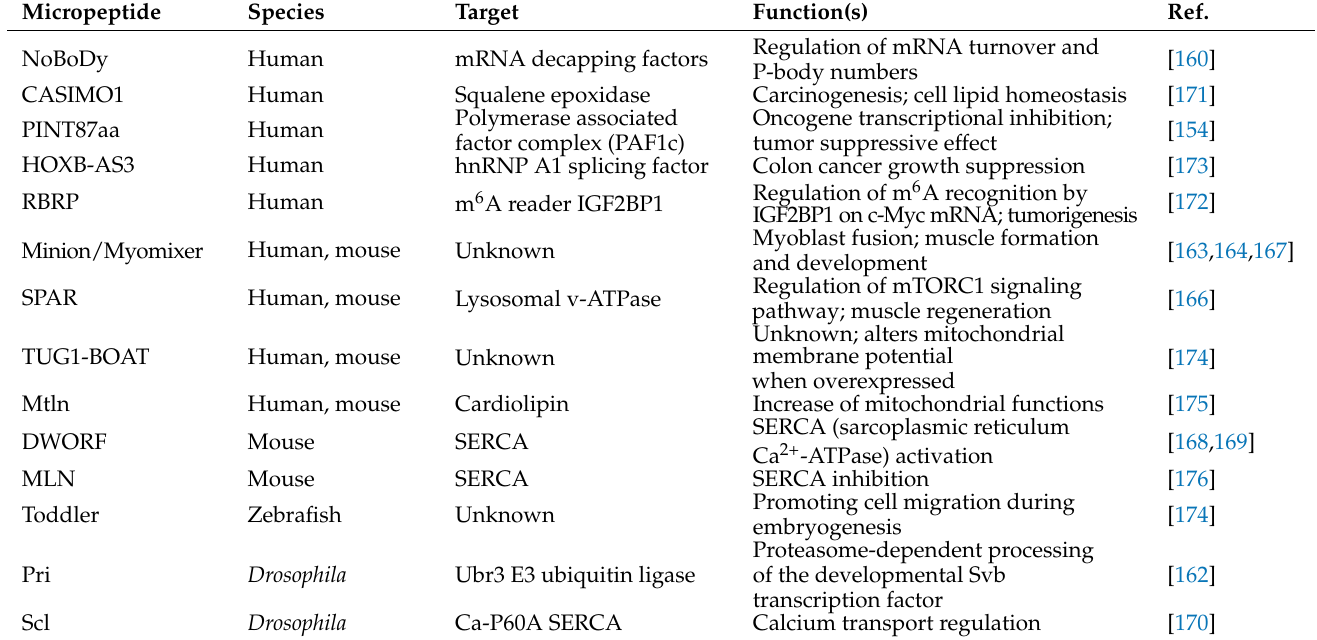
Table 1. Examples of functional lncRNA-derived